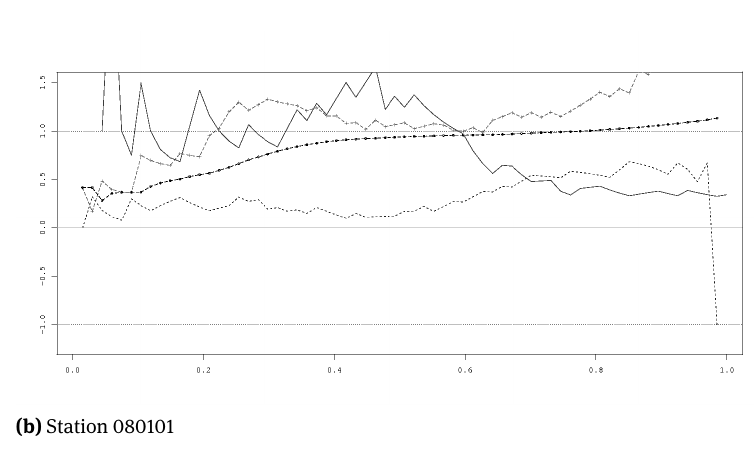
= 0) or ∈ [−1, 1), ˆ χ U U